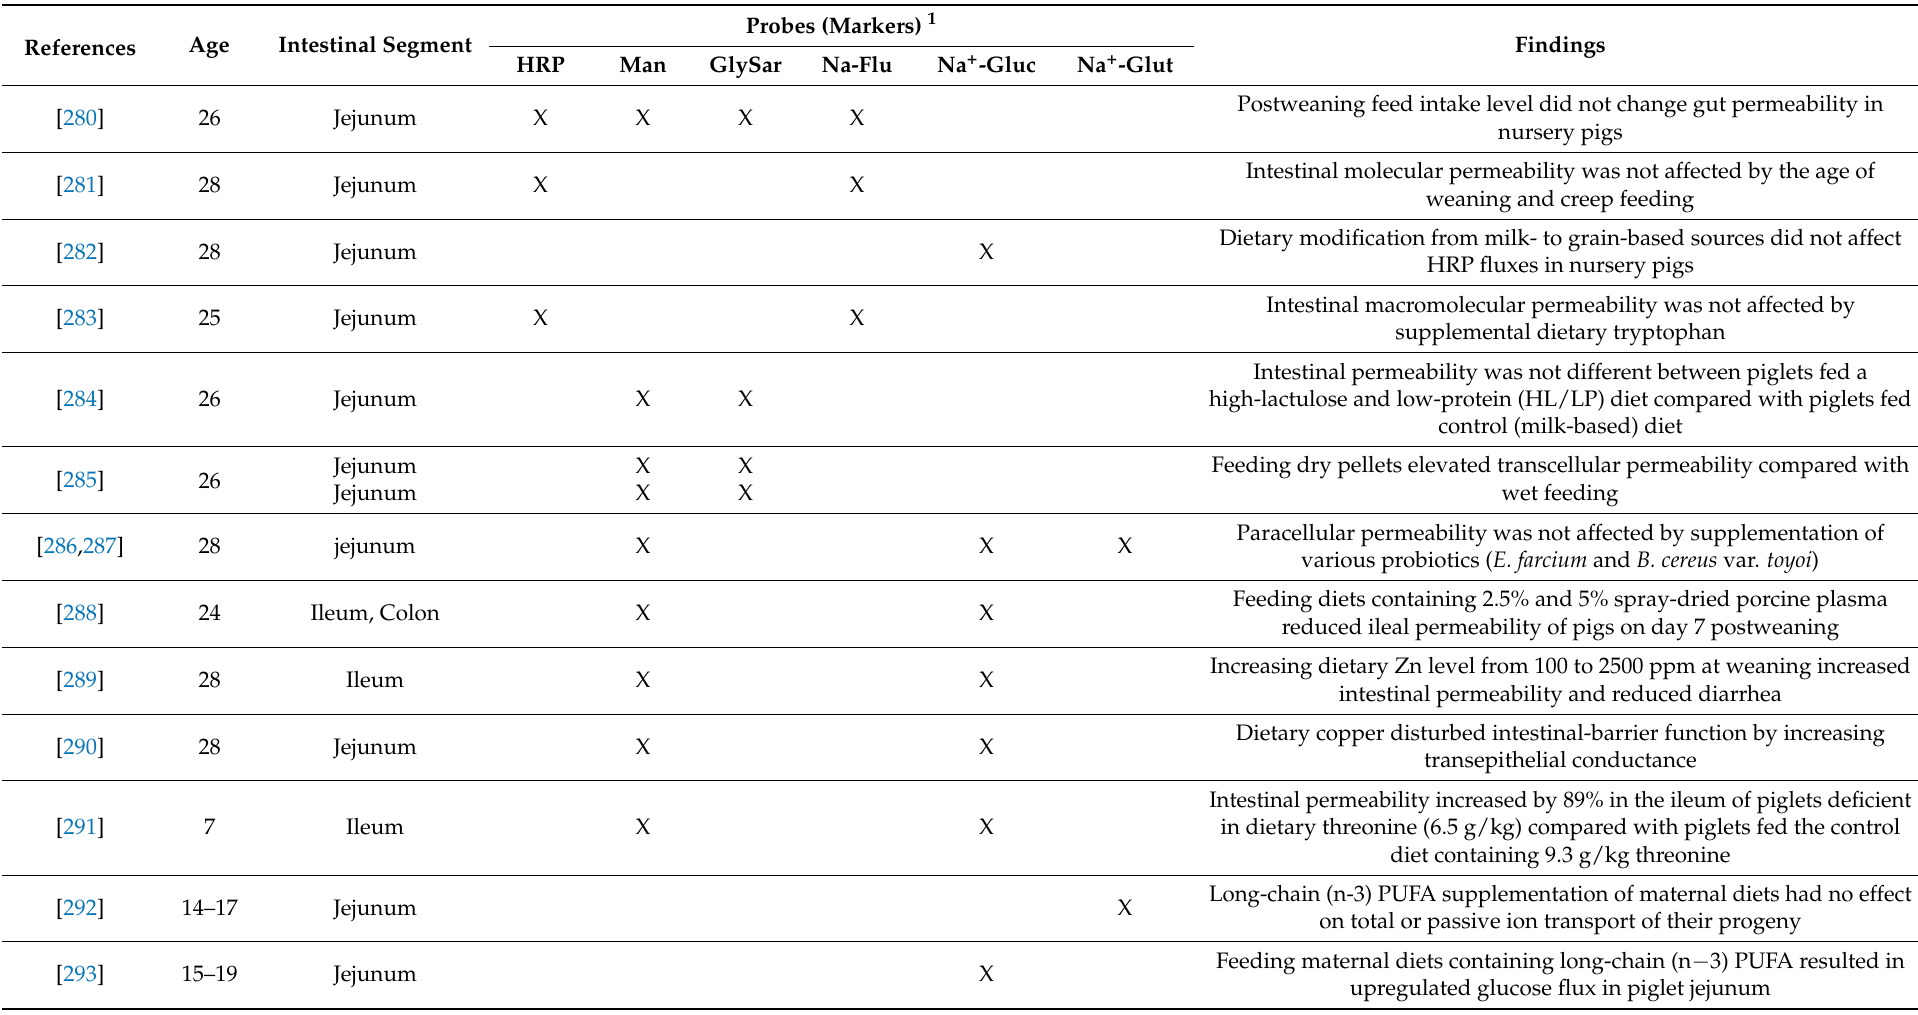
Table 13. Summary of results from ex vivo studies to evaluate intestinal permeability of nursery pigs with Ussing